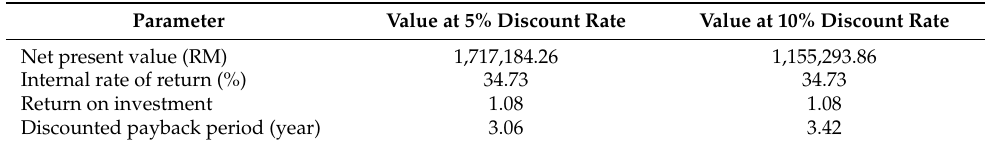
Table 6. Results of